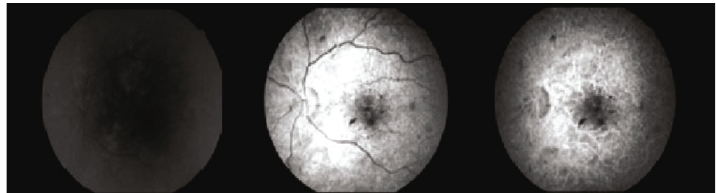
Figure 4: Fluorescein angiography of the left eye at